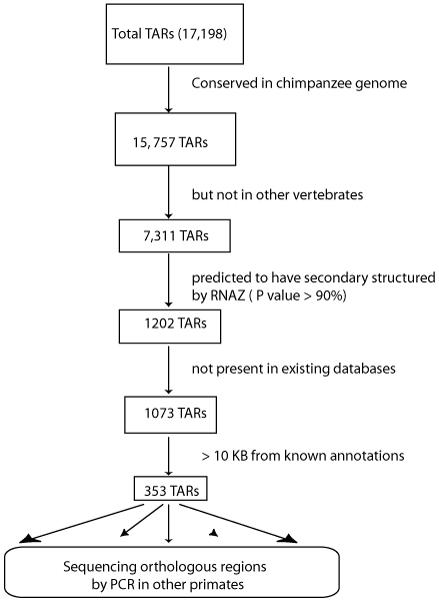
A flow chart of the analysis pipeline.